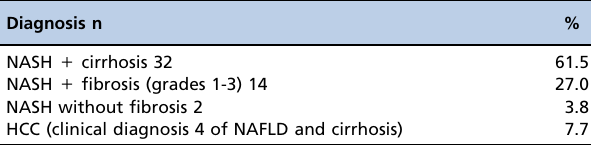
Table 2 - Histological diagnosis of the patients with nonalcoholic steatohepatitis and hepatocellular carcinoma (n=52). Diagnosis n